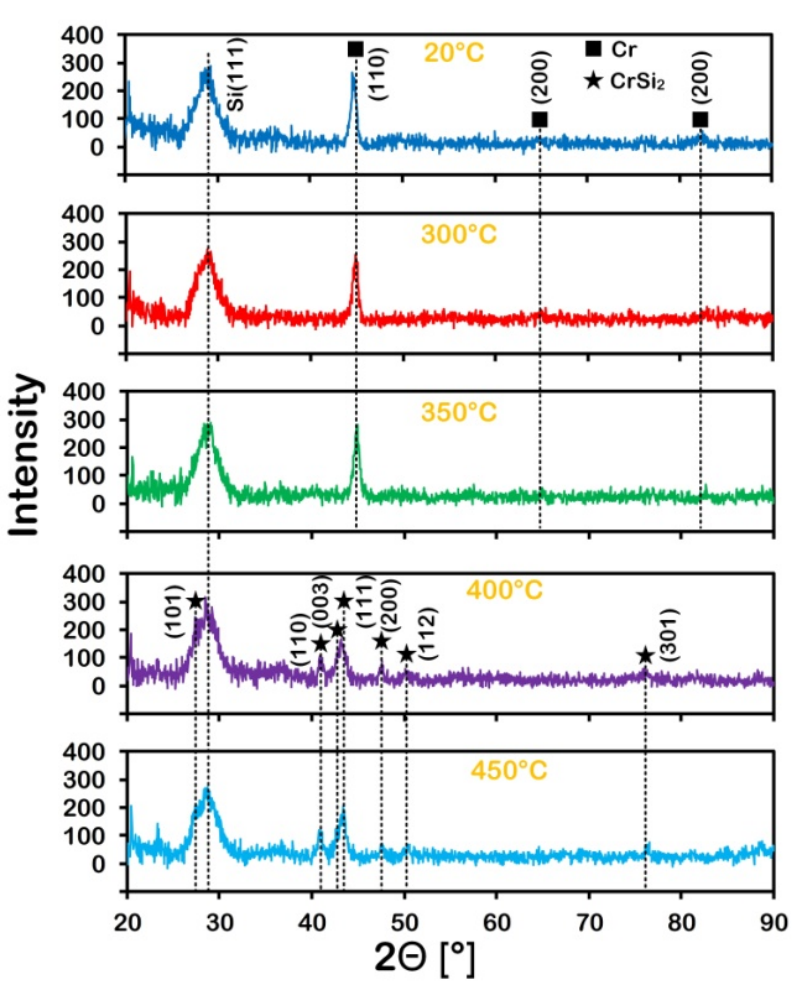
Figure 2. X-ray diffraction (XRD) patterns of Cr coatings in the initial state (20 °C) and after RTT with Cr lines (300 °C, 350 °C) and CrSi 2 lines (400 °C, 450 °C).